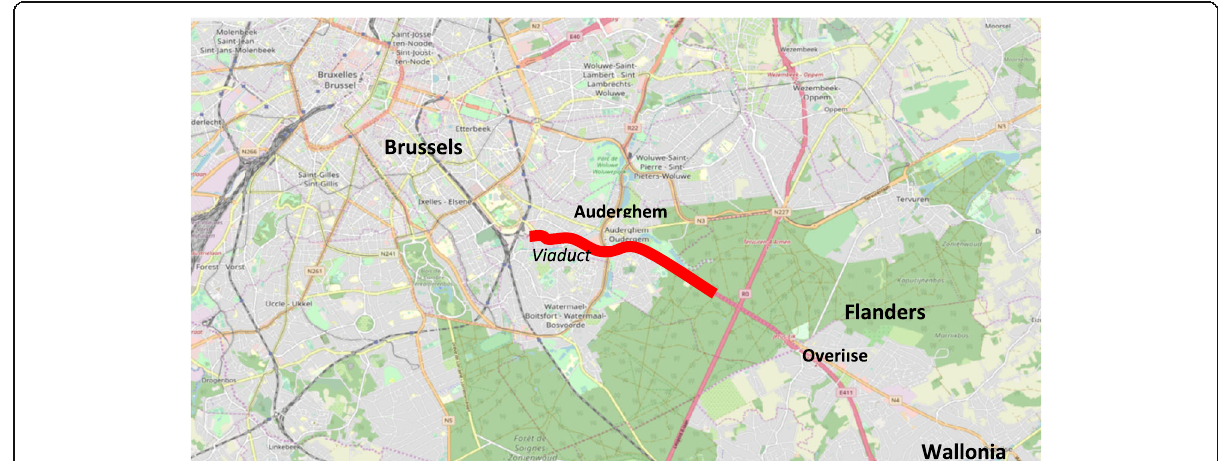
Fig. 6 Location of the viaduct in the Brussels region. Source: OSM, modified by author